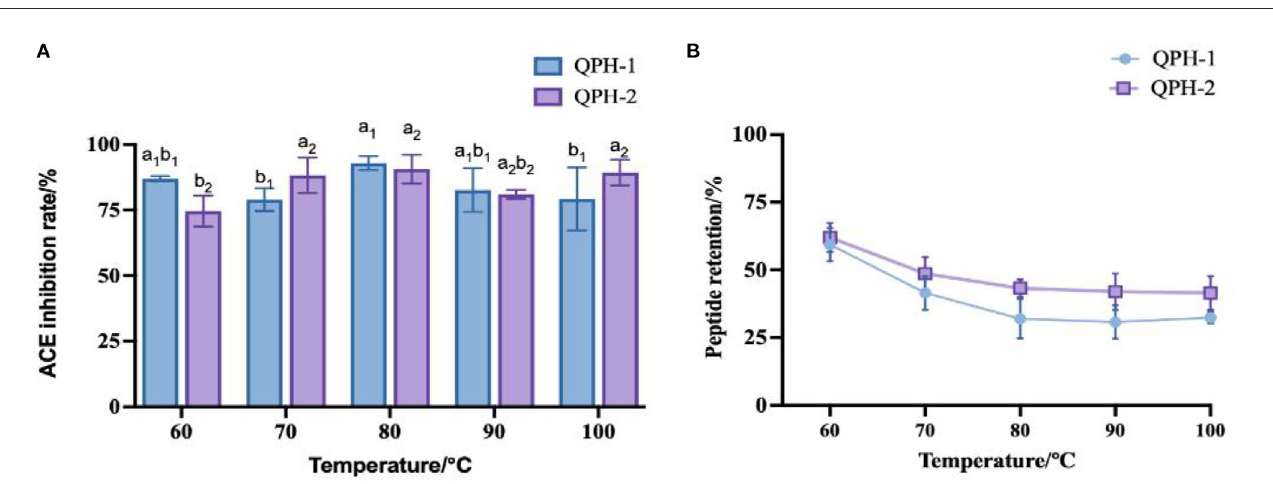
FIGURE6 (A) Effect of samples treated with different temperatures on ACE inhibition rates. (B) Effect of samples treated with different temperatures on peptide yields. Different letters indicates the significant differences among samples ( p -value ≤